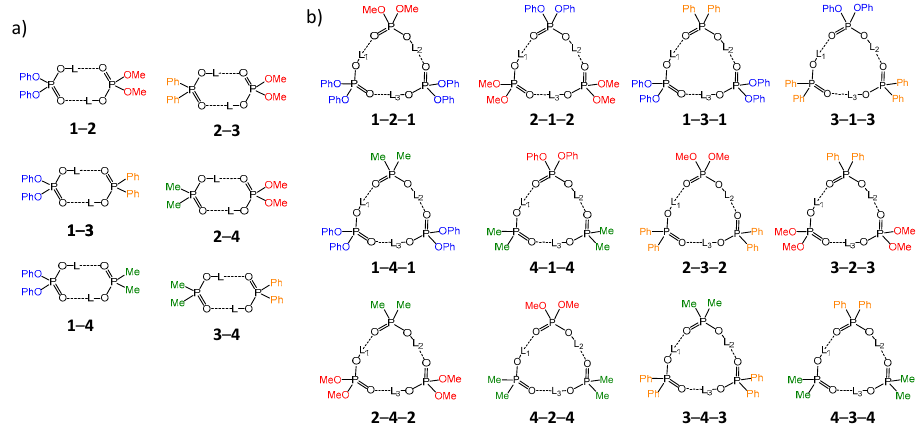
Figure 2. Cyclic heterodimers ( a ) and heterotrimers ( b ) of acids 1 – 4 , studied in this work.